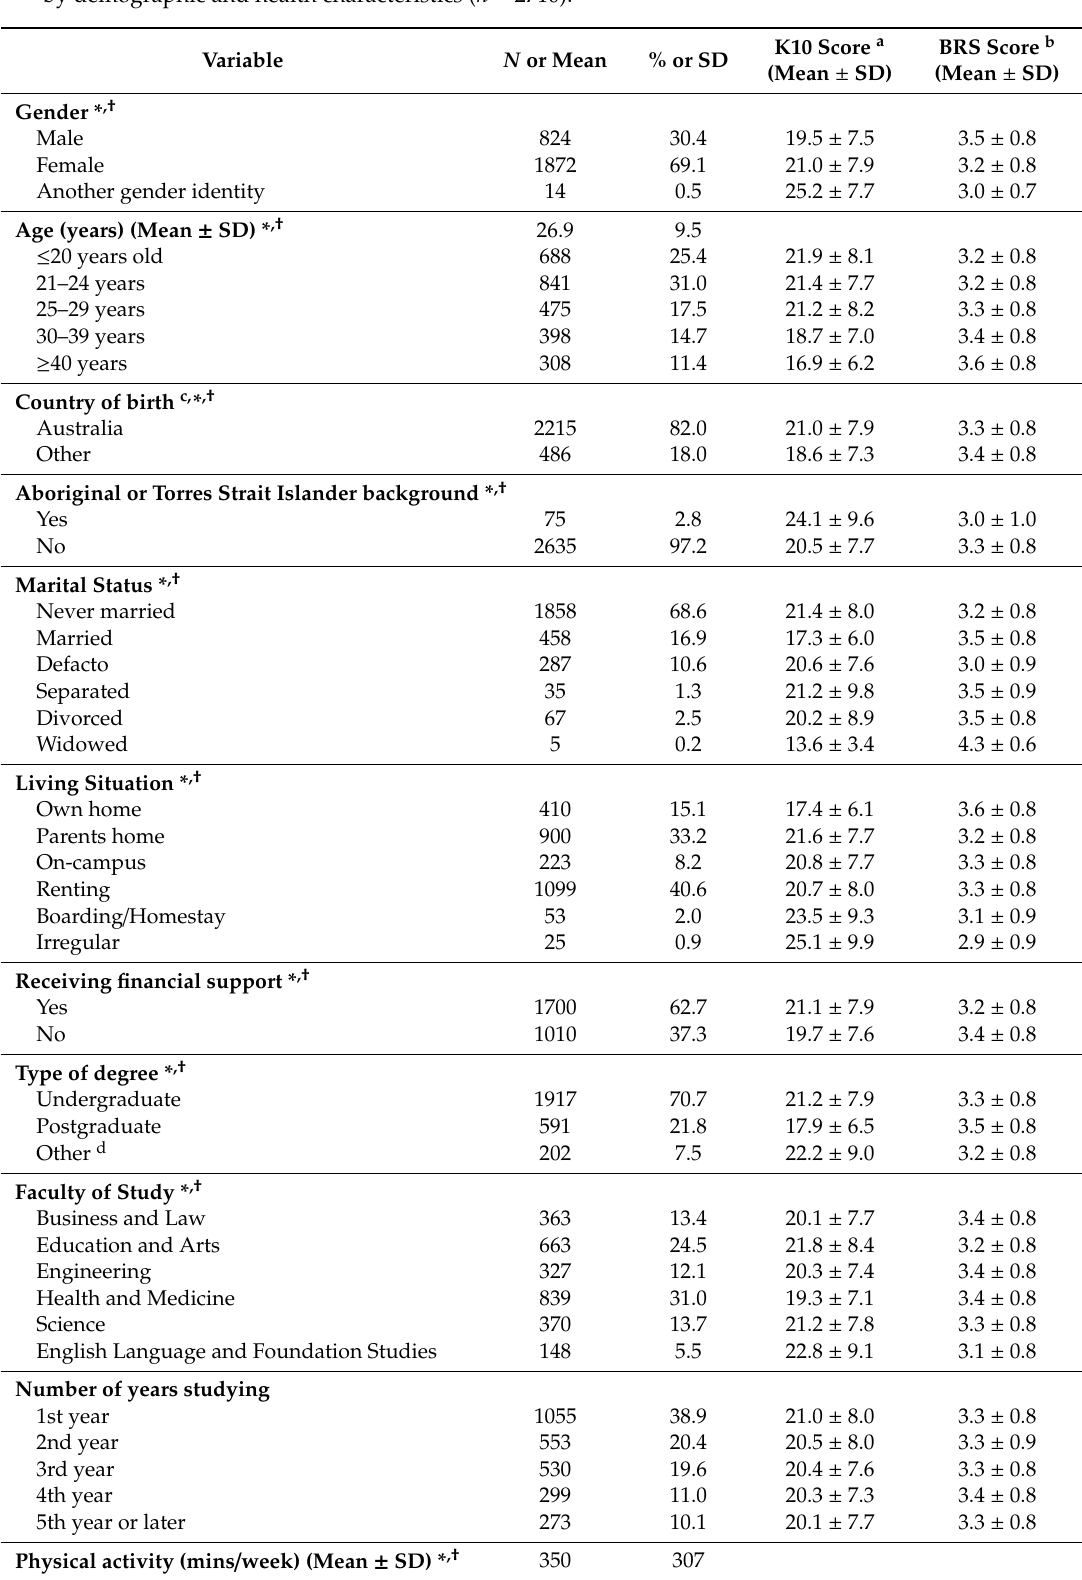
Table 1. Mean psychological distress and resilience scores of a sample of Australian university students by demographic and health characteristics ( n =